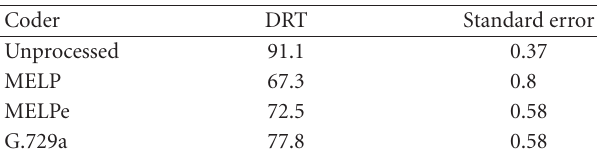
Table 4: DRT scores and standard error with vehicular noise (aver- age SNR ≈ 6